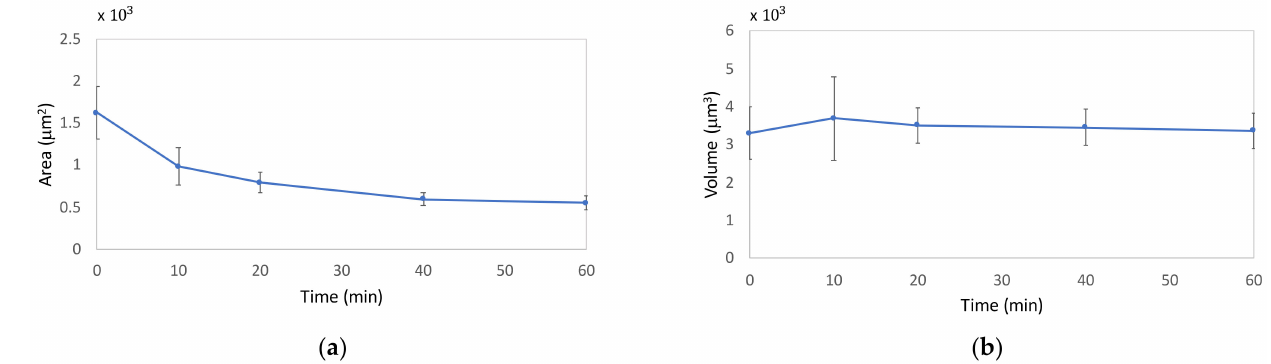
Figure 7. Morphological parameters variations due to Cyt-D at 0, 10, 20, 40, and 60 min. Reported mean values and standard deviations for area ( a ) and volume ( b ) are relative to three independent replicas (m = 3).